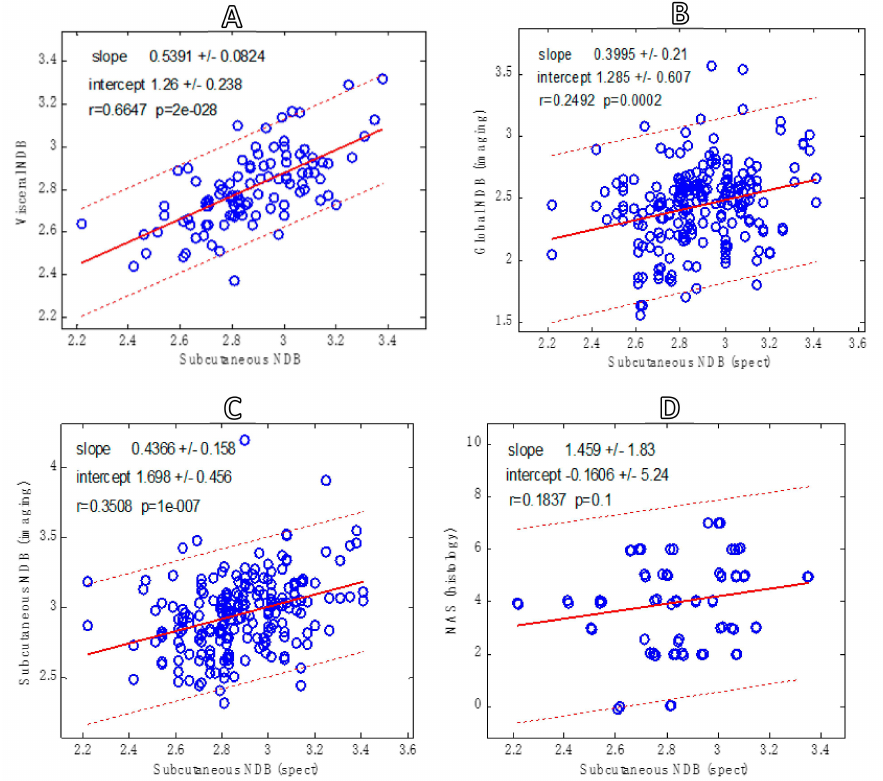
Figure 4. ( A ) Spectroscopy: panel A shows the correlation between visceral and subcutaneous measurements of triglyceride saturation (no. double bonds) by STEAM spectroscopy. ( B ) Imaging: panel B compares estimates of the subcutaneous NDB versus the globally estimated NDB over all pixels. Since the global NDB is an (abundance weighted) average of the NDB in all depots, it should be comparable to an average of thepectroscopy values. ( C ) Spectroscopy versus imaging: panel C shows the correlation between NBB estimated in the subcutaneous depot using spectroscopy and imaging. While estimates are similar, the regression parameters do not show 1:1 agreement. ( D ) Spectroscopy NDB versus NAS: Panel D shows the correlation in NDB versus the NAFLD Activity Score (NAS) assessed by histology. A significant correlation was not